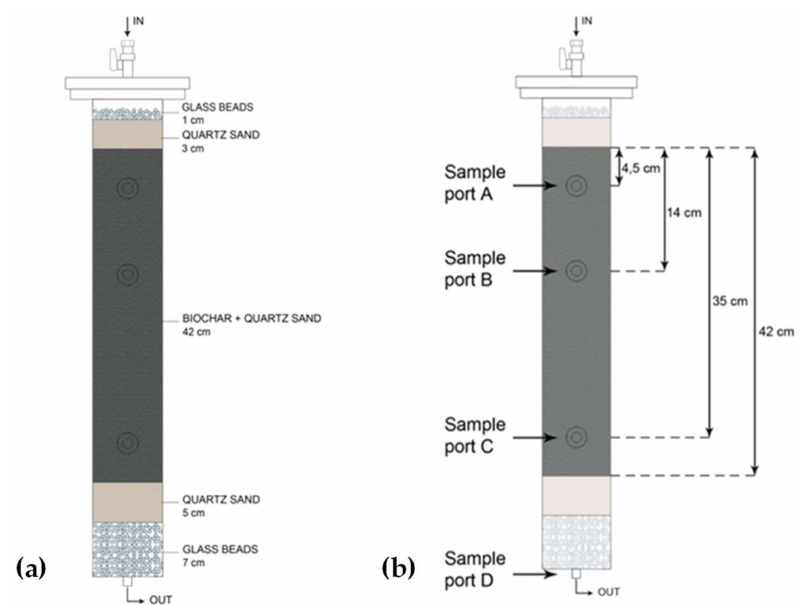
Figure 1. ( a ) Identification of the layer thicknesses of the elements within the column; ( b ) arrangement of the four column sample